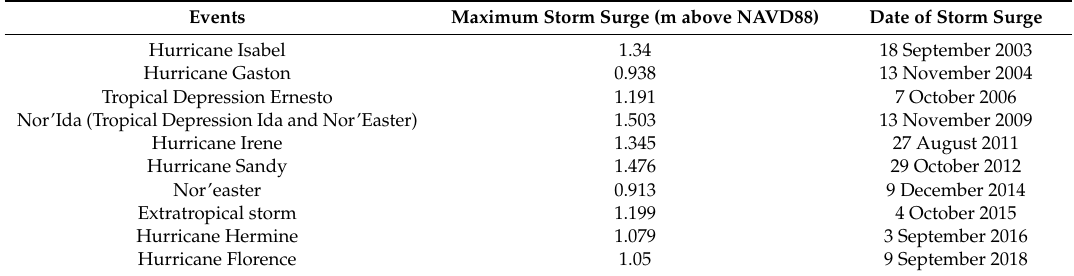
Table 4. Maximum storm surge at the Kiptopeke NOAA station (8632200), Virginia, for di ff erent